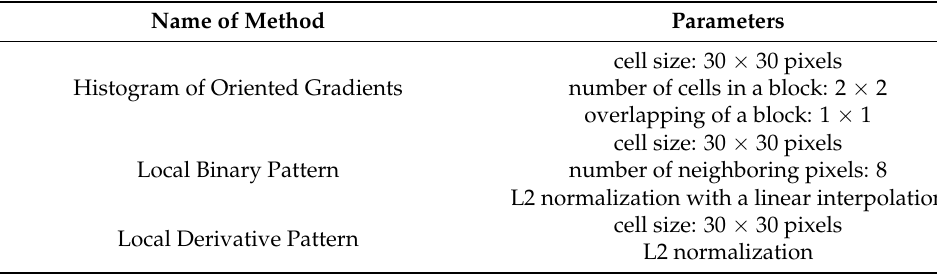
Table 1. Parameters of the algorithms used in the